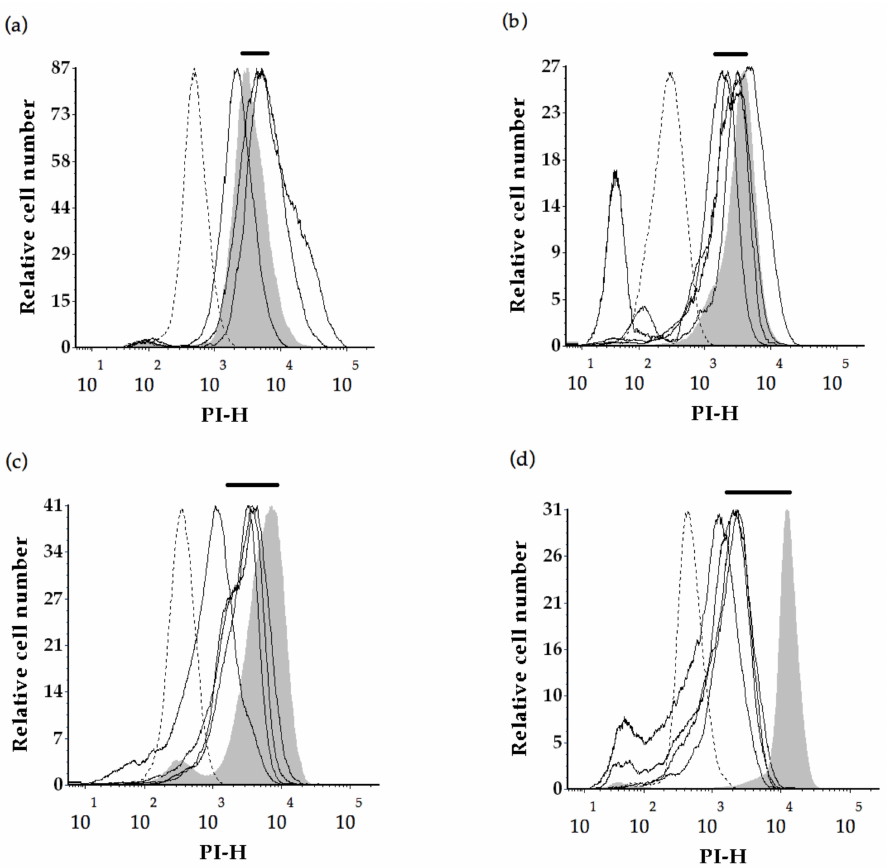
Figure 5. Fluorescence intensities (PI-H) measured for yeast cells from the control lees disgorged after ( a ) 0 months, ( b ) 6 months, ( c ) 12 months, and ( d ) 18 months ageing. Solid bar represents the shift in PI intensities with respect to the labelled control, dotted lines represent the unlabelled control, shaded areas represent labelled control, solid lines represent yeast replicates. PI-H denotes propidium iodide fluorescence peak height.